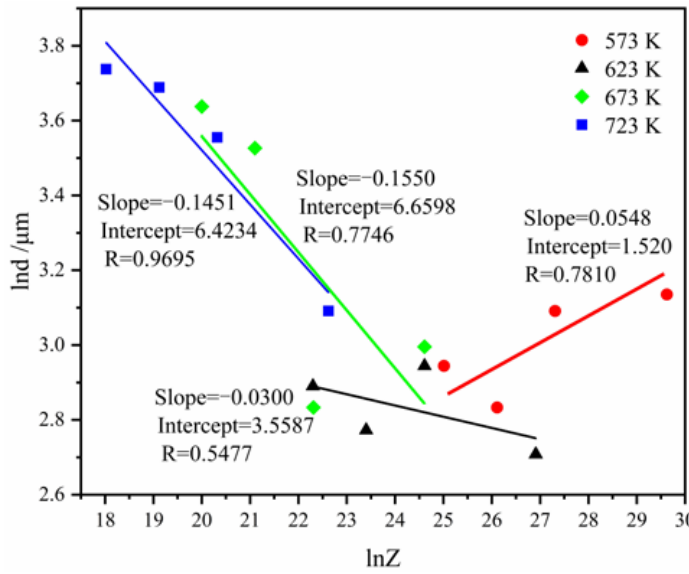
Figure 16. The plot of ln d as a function of ln Z .